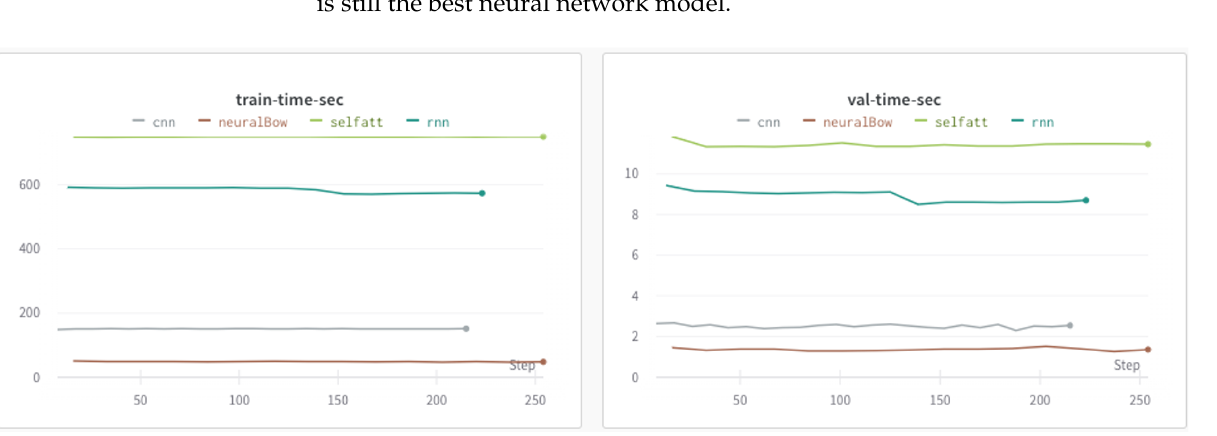
Figure 8. The time cost of training and validating four neural networks.